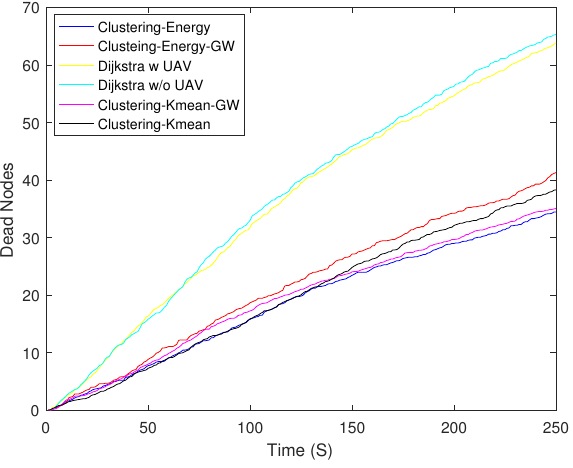
Figure 5. Number of dead